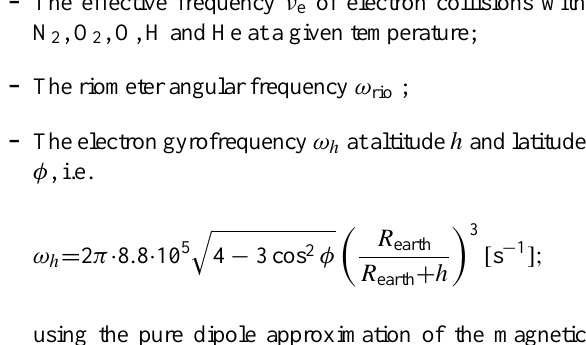
Fig. 1. The layer model of electron heating. For each layer the dissi- pation of RF energy is calculated by the Appleton-Lassen equation. Reflection at layer boundaries is also included in the present version of the heating model, although this effect is generally very small. A layer spacing of 1km is used, as this is the resolution of the required input profiles produced by the SIC model (electron and atomic oxy- gen density) and the MSISE-90 atmosphere (neutral temperature, N 2 and O 2 profiles).